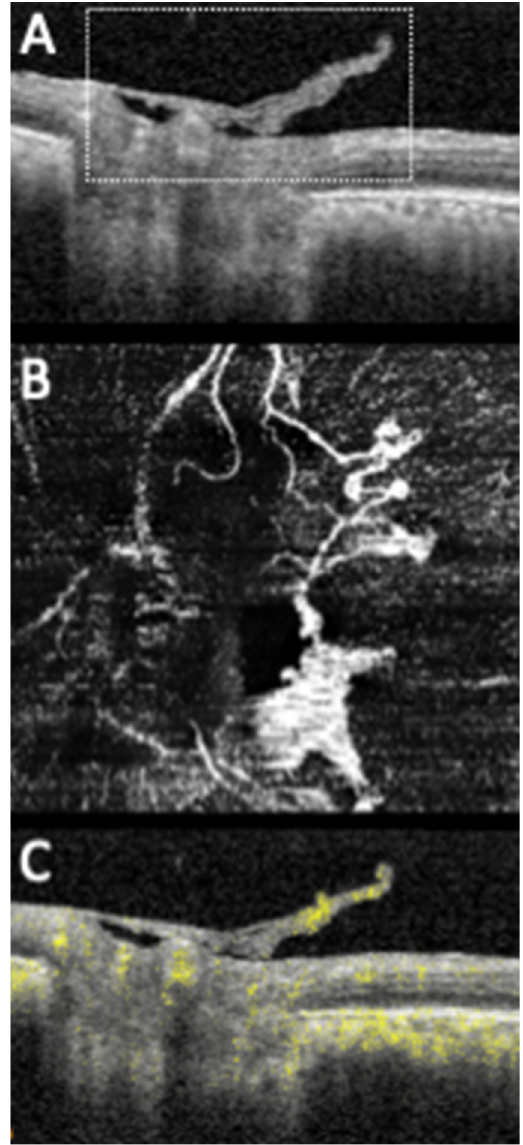
Figure 2. Structural SD-OCT ( A ) of a PDR patient showing a NVD protruding into the vitreous (annotated). Matching OCTA shows the filamentous irregular vessels in the en face image ( B ) with positive flow signal in the temporal buds in the B-scan ( C ), in accordance with NVD activity.